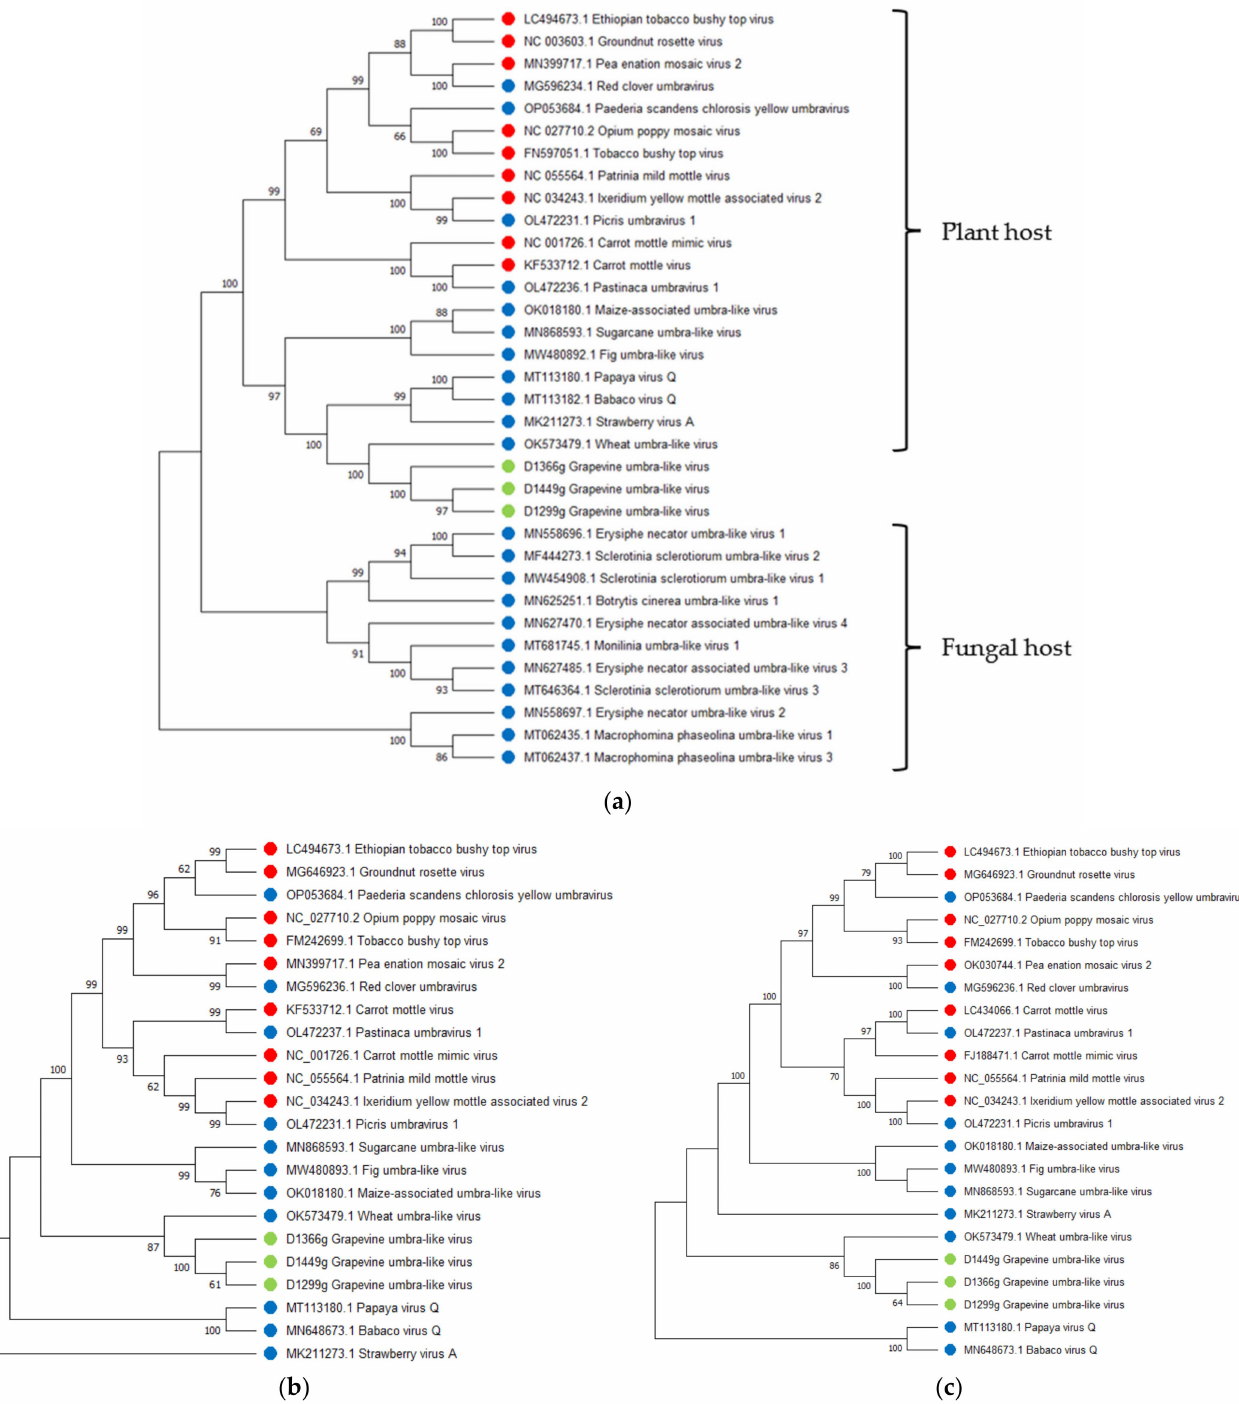
Figure 3. Phylogenetic analysis of ( a ) complete genomes, ( b ) nucleotide sequences of the RNA- dependent RNA polymerase (RdRp) and ( c ) amino acid sequences of the RdRp of grapevine umbra- like virus (marked with a green dot), representatives of the genus Umbravirus (marked with a red dot) and unclassified umbra-like viruses (marked with a blue dot). The tree was constructed using the neighbor-joining method. The numbers at the nodes indicate bootstrap values >60% (1000 replicates). GenBank accession numbers for each isolate are present by virus isolate names and are also in Supplementary Table